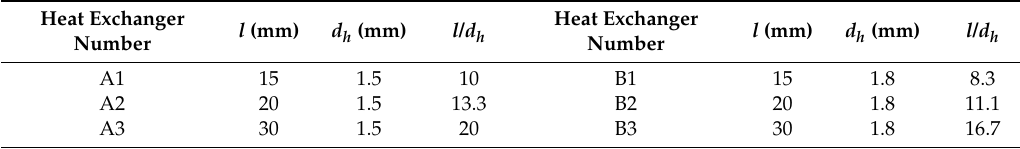
Table 1. Geometrical parameters of the tested heat exchangers.